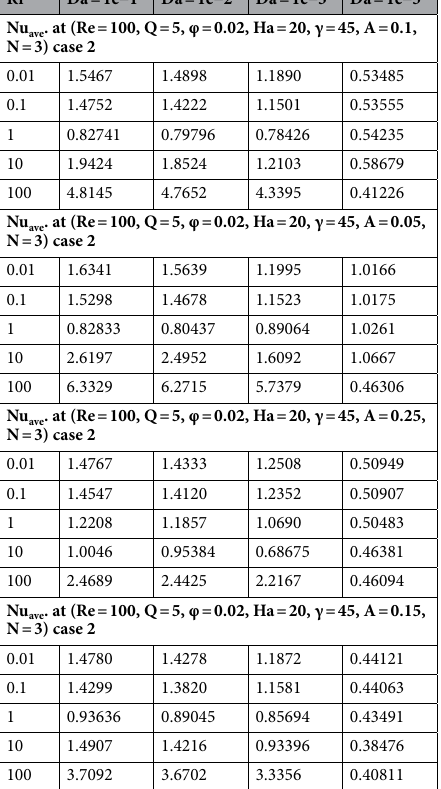
Table 10. Effect of Ri, Da and A on the average Nusselt number for Case